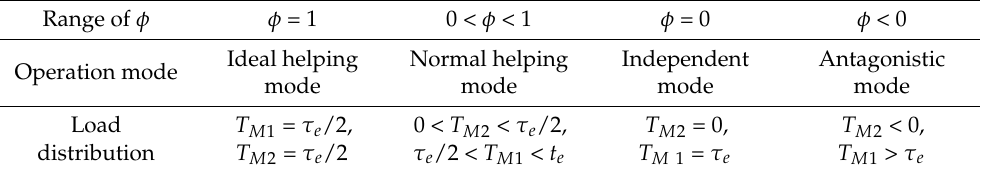
Table 2. The relationship between the operation mode of the VSA and its load